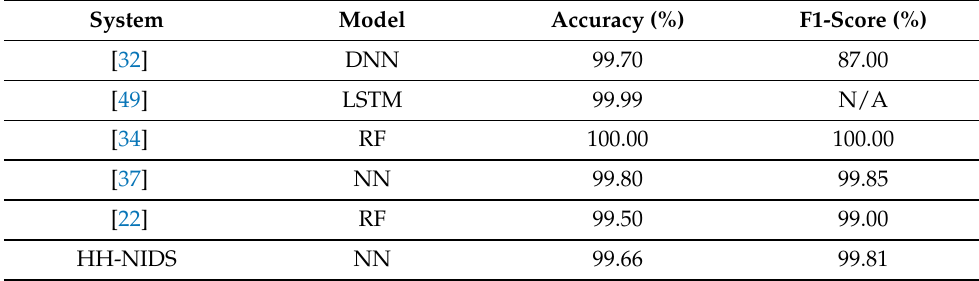
Table 10. Result comparison to related works in the IoT-23 dataset.